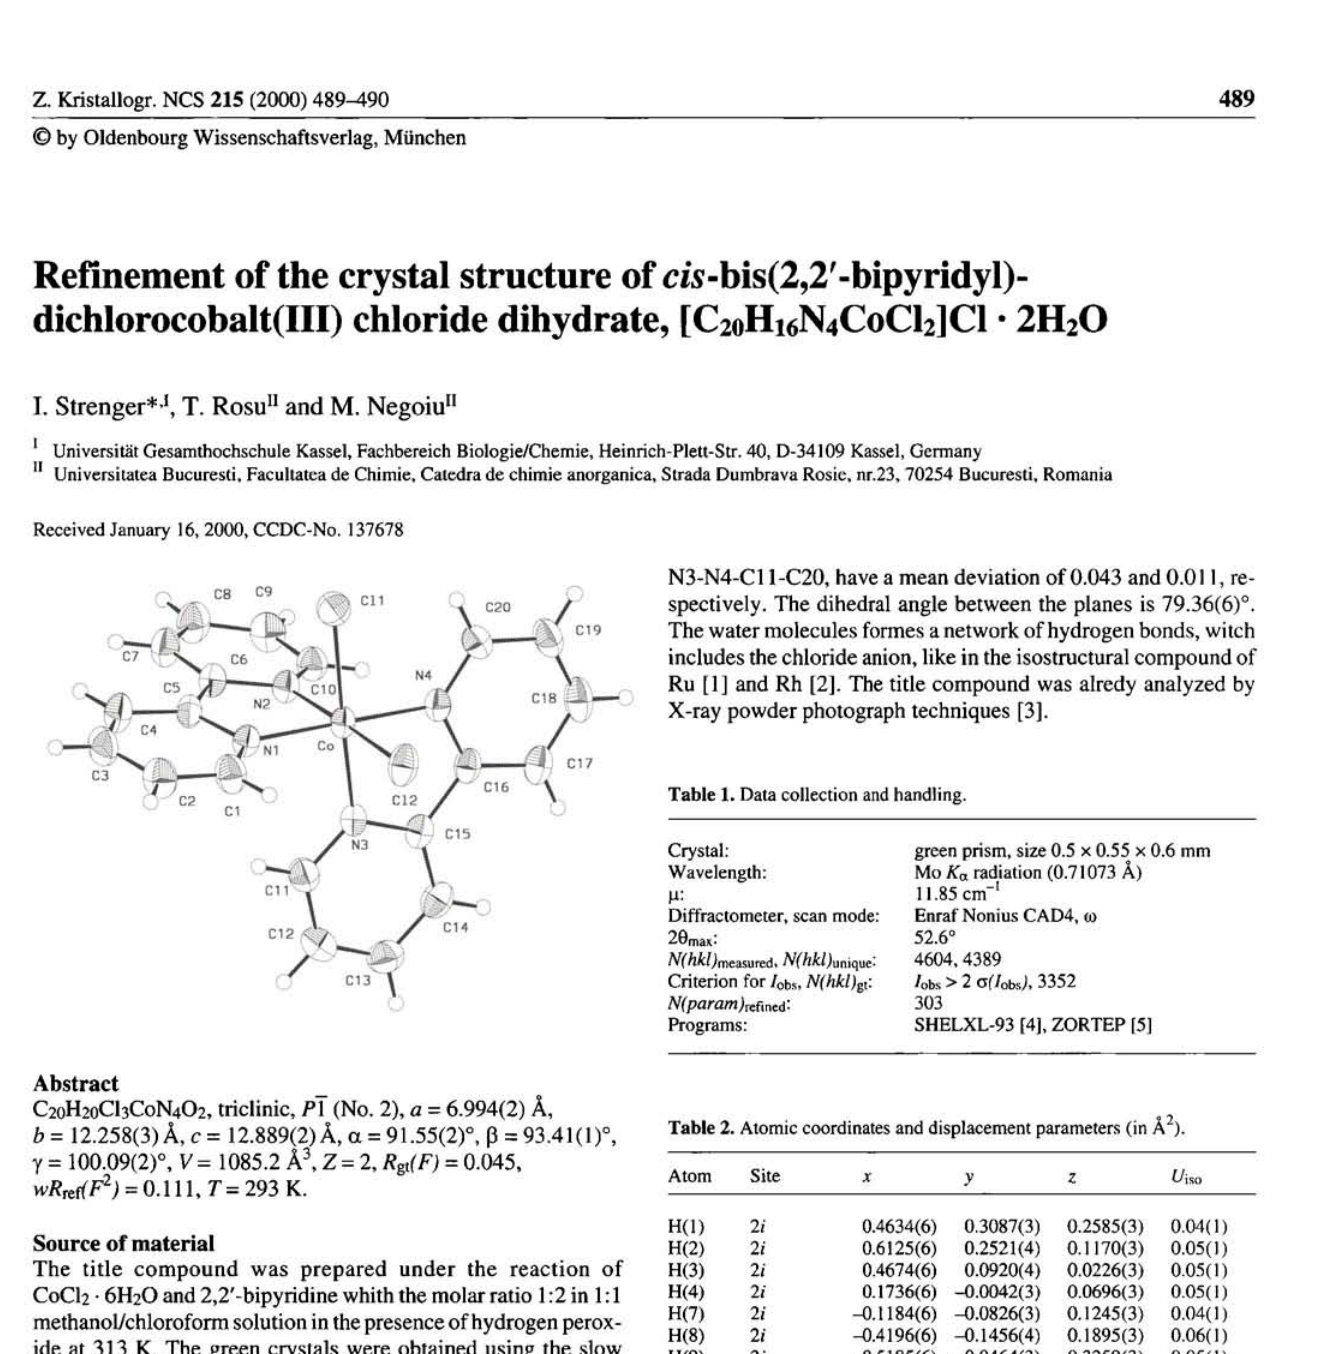
Table 2. Atomic coordinates and displacement parameters (in Â 2